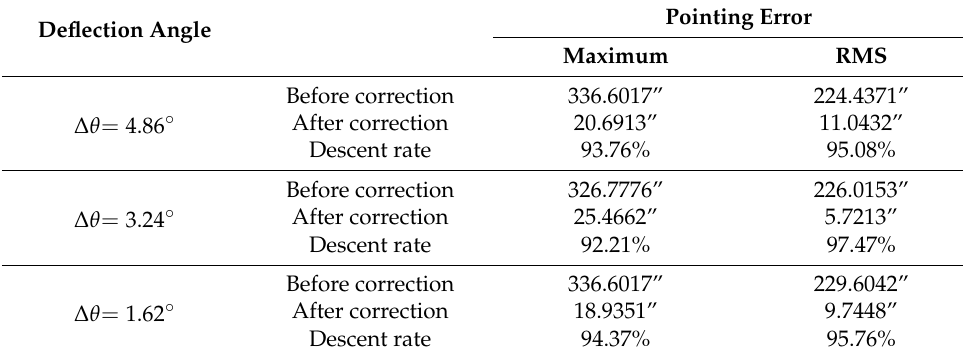
Table 5. Experimental results of forward solution error correction.